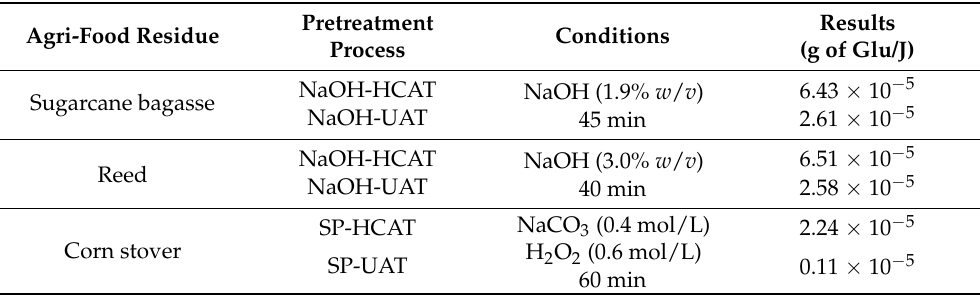
Table 3. Comparison of energy efficiency during various HC-and US-assisted processes UAT and HCAT on different agri-food